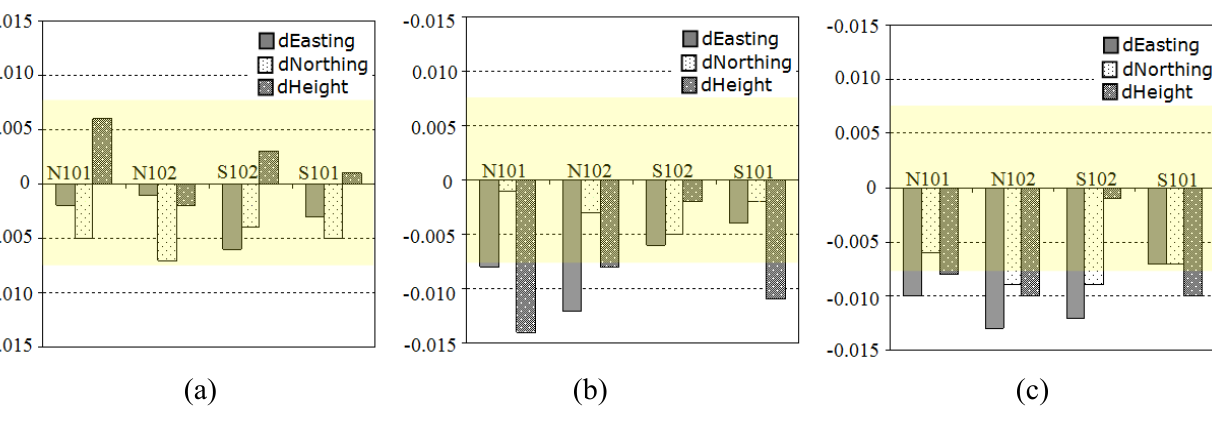
Figure 10. Coordinate differences of (a) the 1st and 2nd campaigns (b) the 2nd and 3rd campaigns (c) the 1st and 3rd campaigns (in meters) at the deformation benchmarks. Confidence intervals at 99% confidence level are indicated with a transparent layer on the